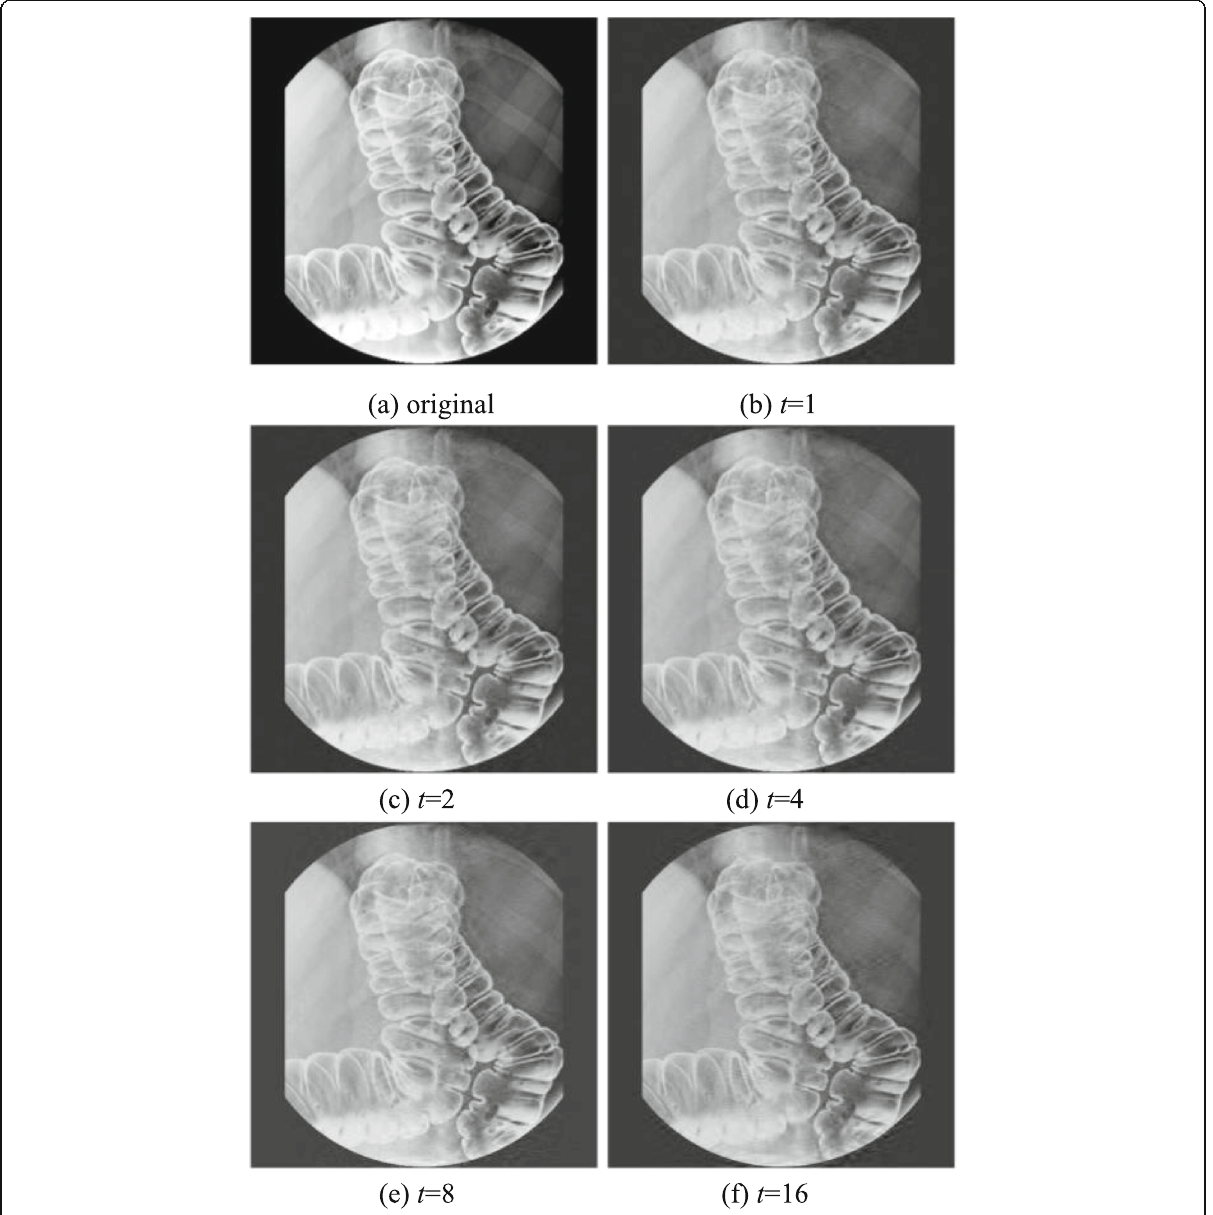
Fig. 5 Comparison of the reconstructed images with different dimensions of measurement matrices. (OT-colon, M = 256, N = 512, ℓ 0 -minimization with ρ = 0.8). Frame a is the original image; Frame b is the reconstructed image from the original in Frame a using the matrix Φ 256×512 ; Frame c is the reconstructed image using the matrix Φ 128×256 ; Frame d is the reconstructed image using the matrix Φ 64×128 ; Frame e is the reconstructed image using the matrix Φ 32×64 ; Frame f is the reconstructed image using the matrix Φ